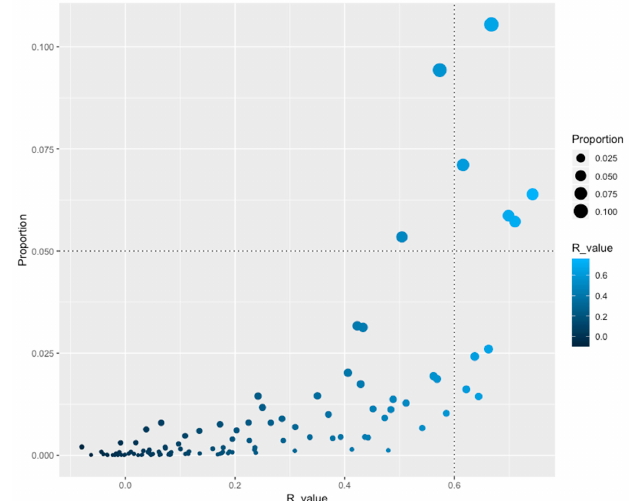
Figure 1. Proportion of TFs(Transcription factors) as a function of R -values. On the X-axis is the indicated the R -value (Pearson correlation) between the genome size and the number of proteins per family of TFs. On the Y-axis is the proportion of TFs versus the dataset. An R -value ≥ 0.6 was considered significant (vertical dotted lines at 0.6). A value ≥ 0.050 was considered as abundant (horizontal dotted lines). Circle size denotes the proportion of the families and color the R -value.